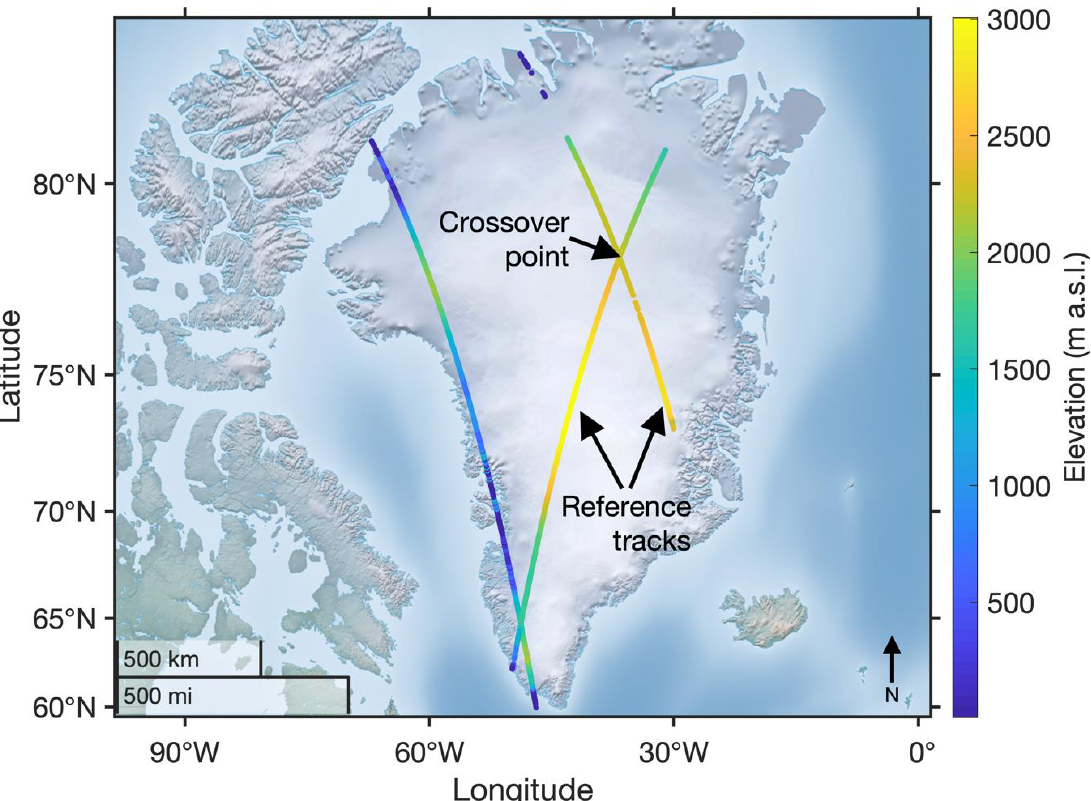
Figure 2. Example of GLAS/ICESat orbital reference tracks, crossover point, and 27,766 unique surface elevation measurements collected on 20 February 2003 obtained from the GLAS/ICESat L2 Antarctic and Greenland Ice Sheet altimetry Data (GLAH12), Version 34 (https://nsidc.org/data/GLAH12/). ICESat data are produced by the GLAS Science Team at the ICESat Science Investigator-led Processing System (I-SIPS) at NASA/GSFC and are archived by the National Snow and Ice Data Center (NSIDC) DAAC.